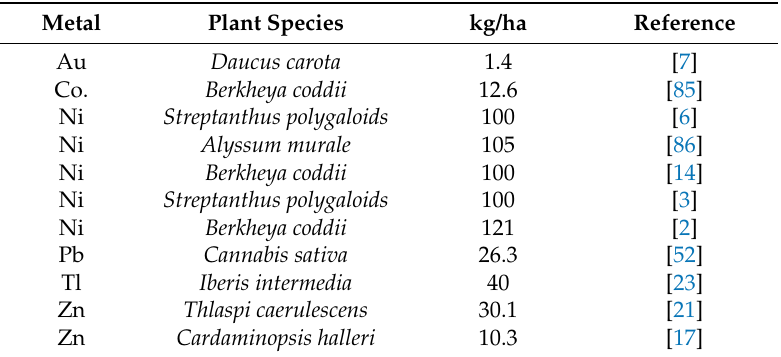
Table 5. List of metal yields reached during agro-mining